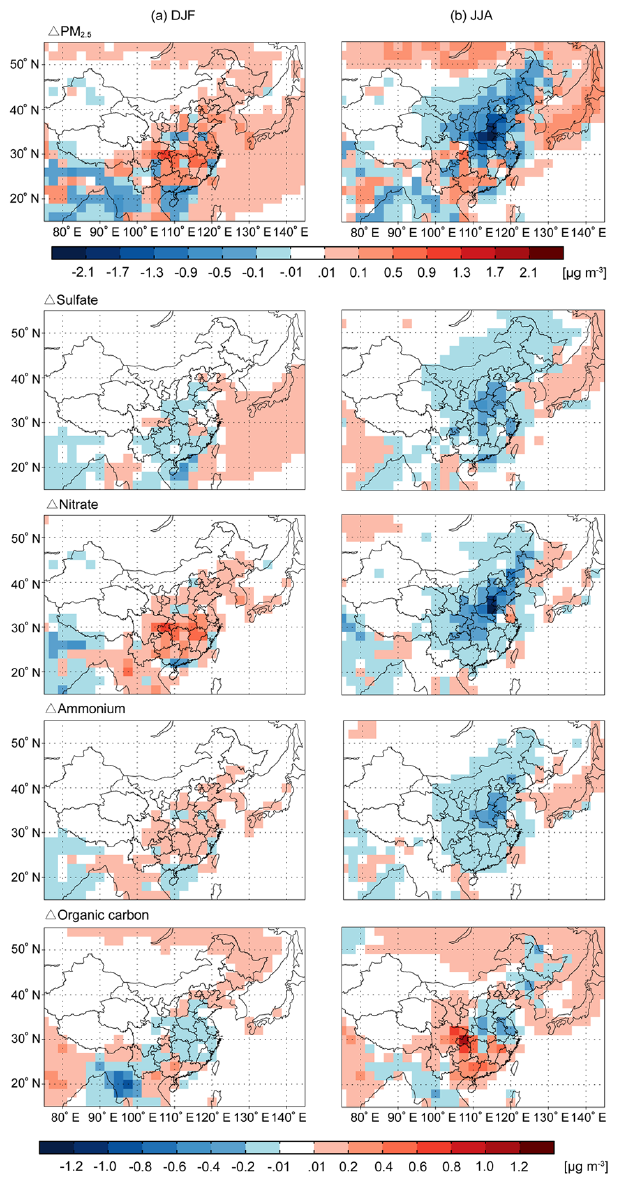
Figure 7. Changes in seasonal mean surface concentrations of total PM 2 . 5 , sulfate, nitrate, ammonium and organic carbon in East Asia arising from 1980–2010 changes in land cover and land use alone ([ CTRL ] – [ S_LCLU ]).